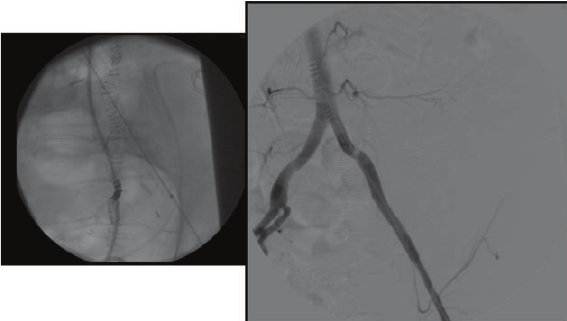
Figure 2: Deployment of a stent-graft on left common iliac artery.